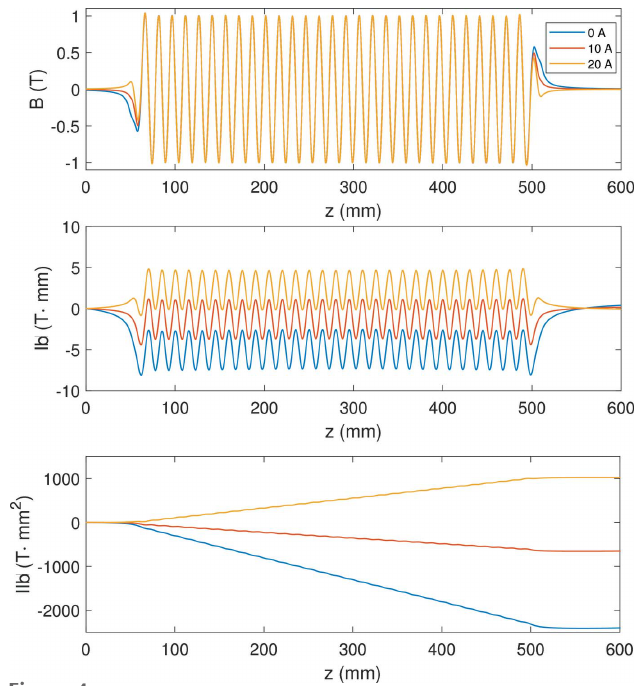
Figure 4 The magnetic field on-axis (top) and the corresponding first integrals (middle) and second integrals (bottom) with 0 A, 10 A and 20 A correction currents, respectively.